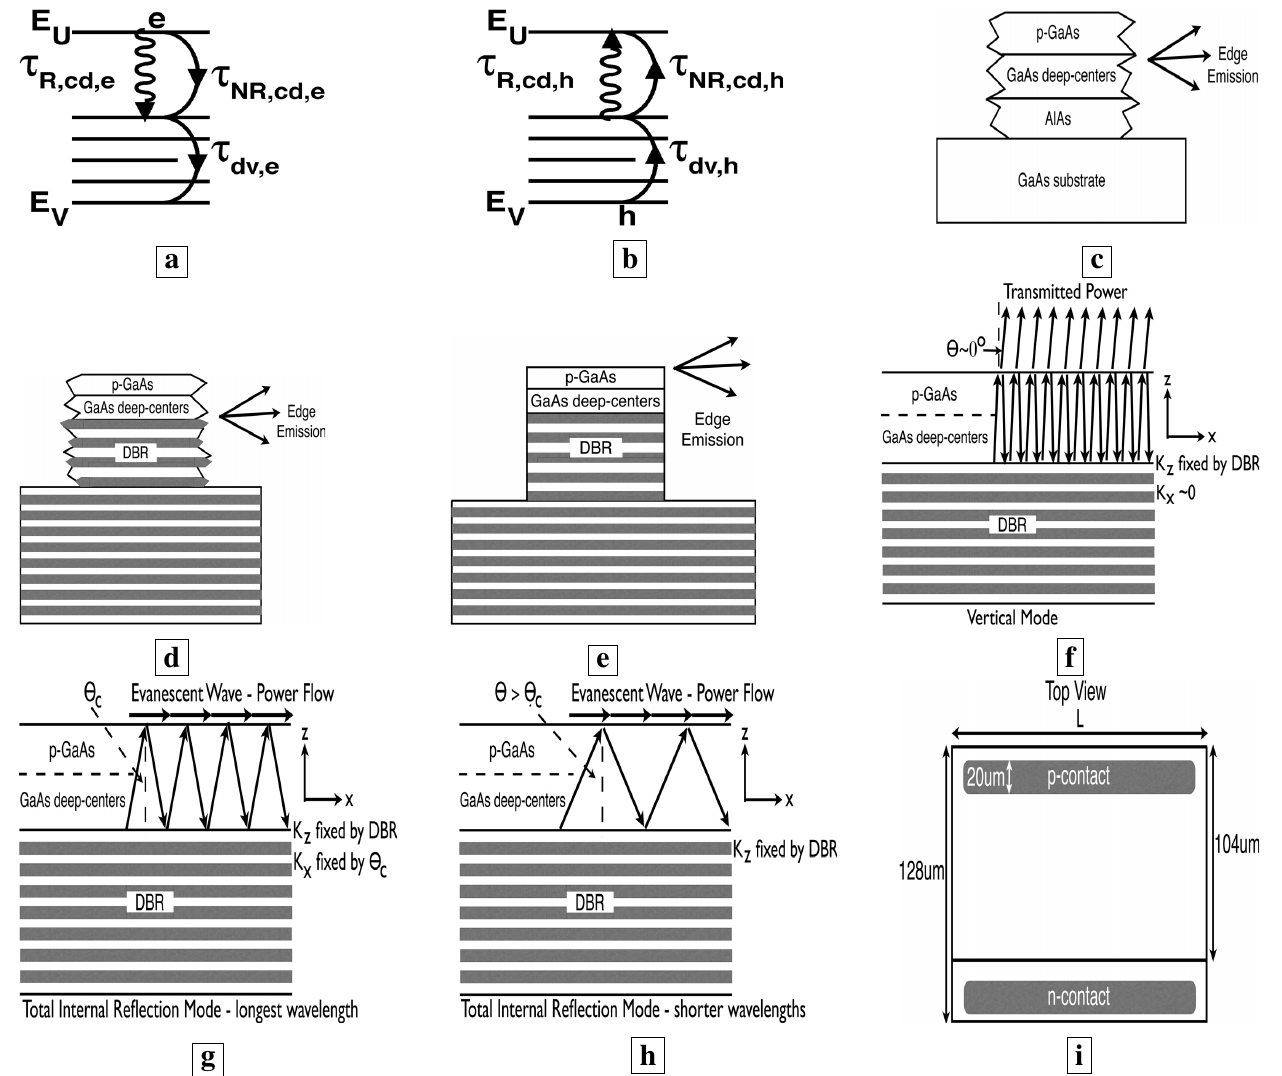
Figure 1 . Lifetimes and measurement geometries [5]. a, Lifetimes for electrons. b, Lifetimes for holes. c, Single-pass measurement from the edge of Sample F. The active layer was not inside a resonant cavity or waveguide. d, Single-pass measurement from the edge of Sample G. A bottom mirror (DBR) was added to increase the single-pass optical length. The rough wet-etched facets preclude the optical-feedback characteristic of resonant cavities. e, Edge emission from Samples H-N. The RIE facets allow a resonant cavity, with its characteristic optical-feedback. f, Lossy “vertical” waveguide mode, which is normally incident upon the sample surface and whose longitudinal wave vector K is nearly zero. X 70% of the incident power is transmitted vertically and lost through the top surface. g, Low-loss longest wavelength total-internal-reflection (TIR) mode. Here, rays from within the semiconductor are incident upon the sample surface at the critical angle θ for TIR. h, C Shorter wavelength TIR mode. Here, rays from within the semiconductor are incident upon the sample surface at an angle greater than θ . This mode makes fewer passes through the C active region. i, Top view of the semiconductor surface showing the pixel